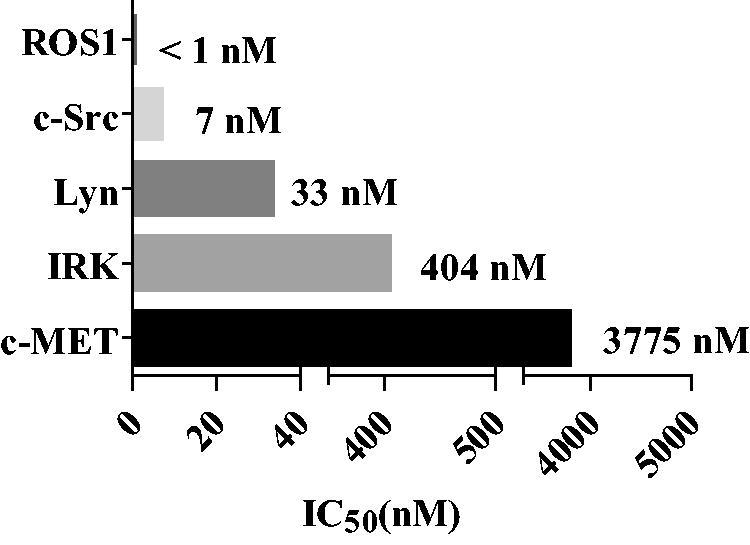
Kinase-inhibitory activities of the 10g against ROS1, c-Src, Lyn, IRK (insulin receptor kinase) and c-Met.